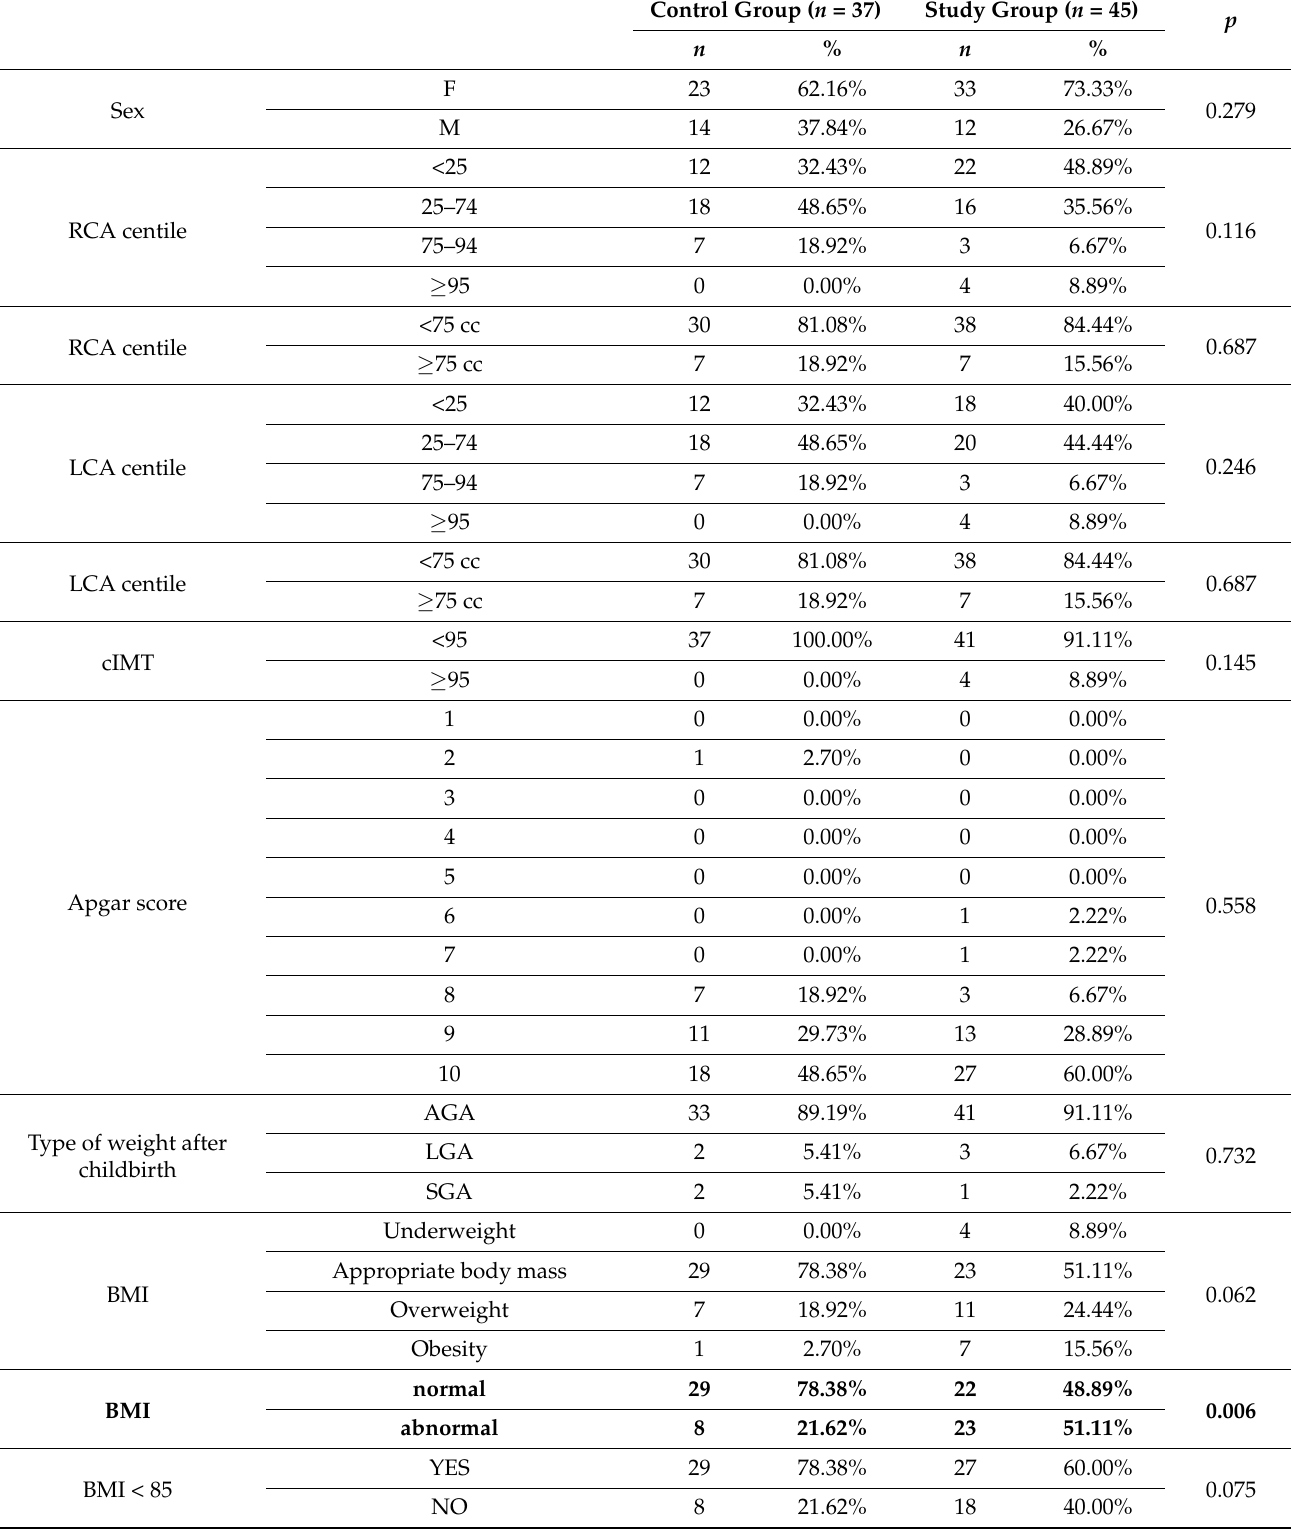
Table 1. Baseline characteristics of the study